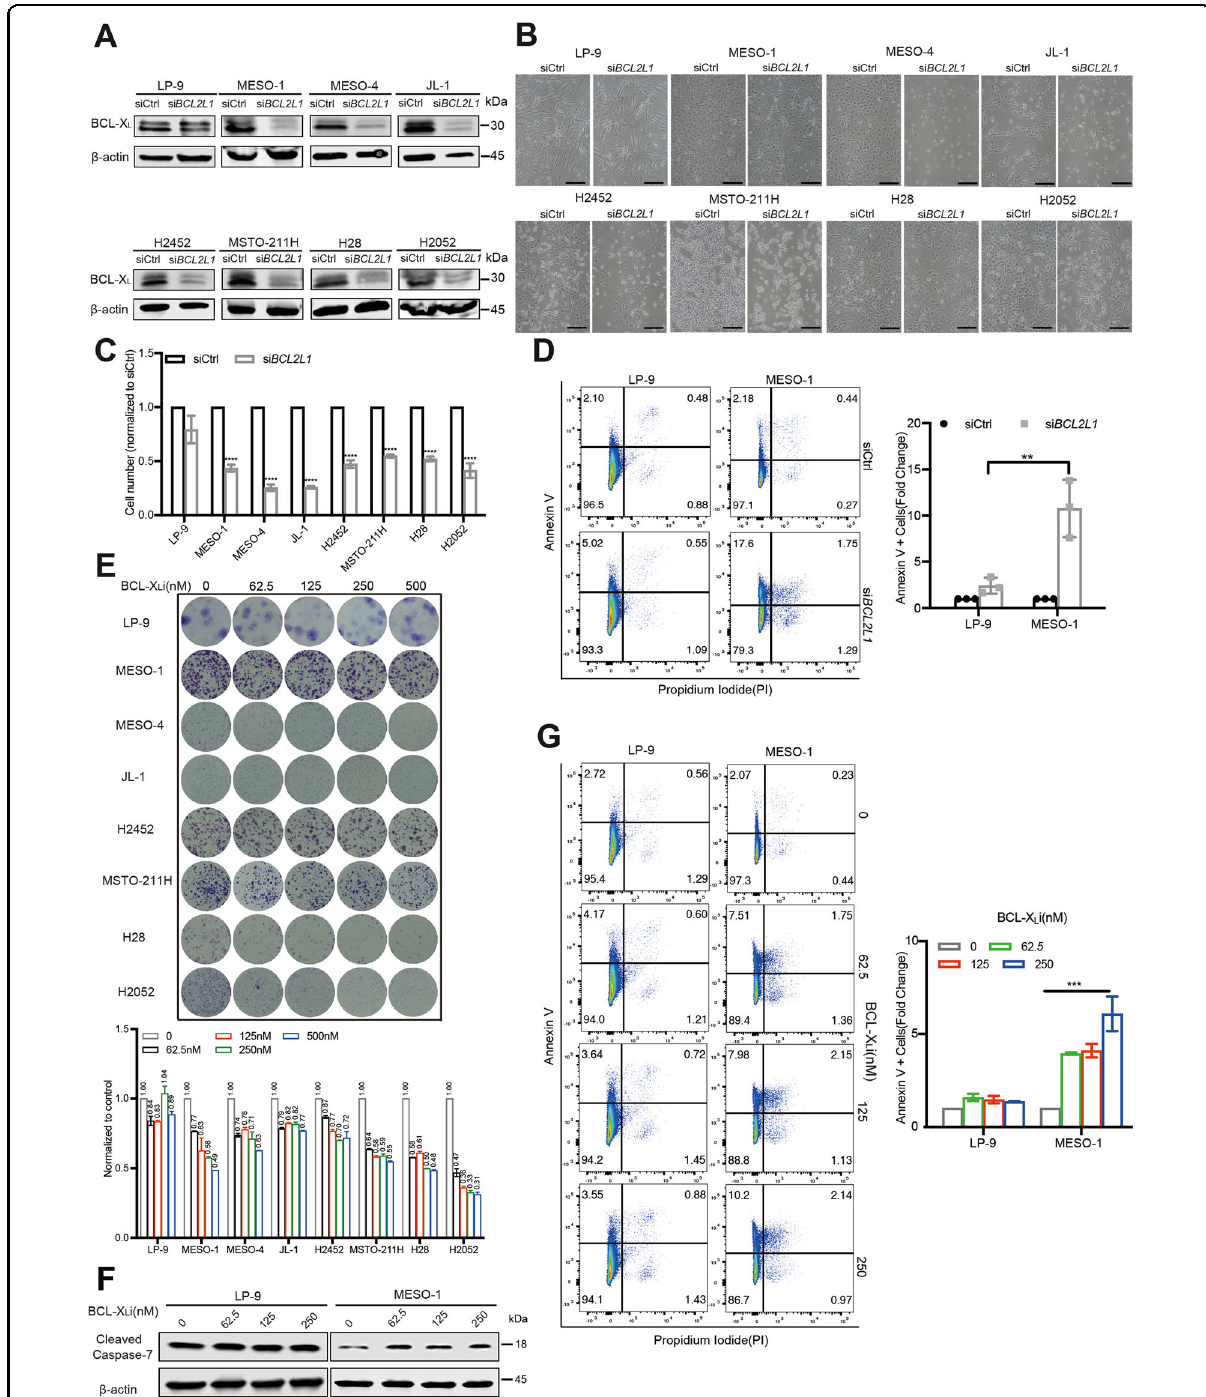
Fig. 2 (See legend on next